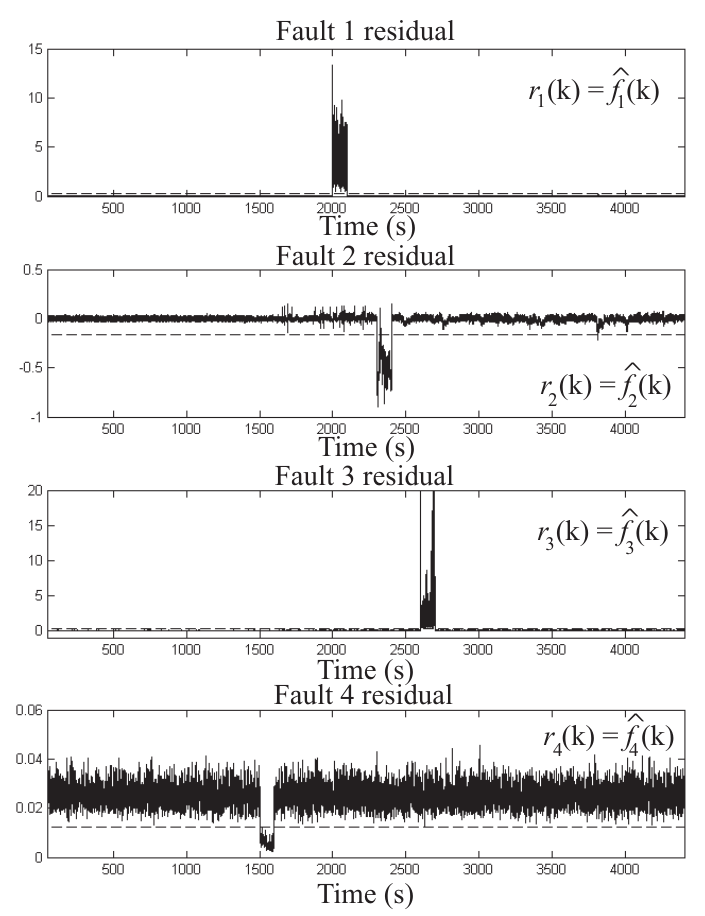
Figure 6. Estimated signals (continuous line) ˆ f i ( k ) and fixed thresholds (dashed line) for Faults 1, 2, 3, and